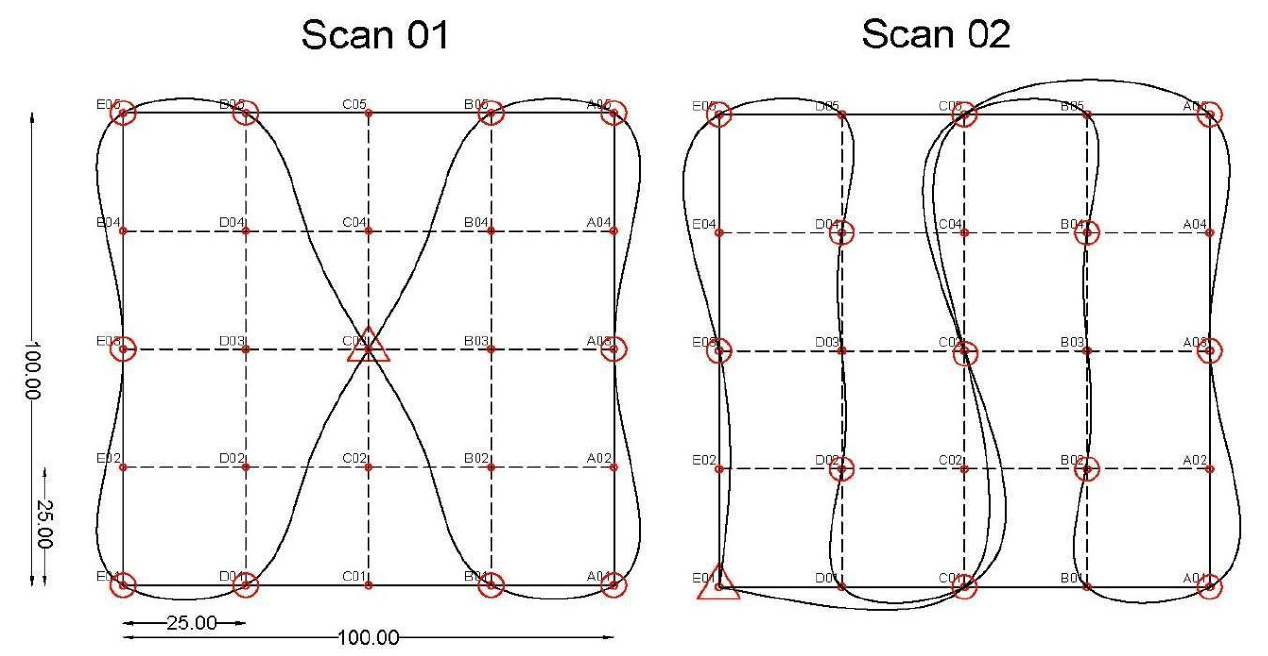
Figure 3. Representation of the 100 m × 100 m marteloscope and its 16 sections, each 25 m × 25 m, to show the two scanning paths tested. The red triangle is start‑and‑end point for each scan, the small red dots represent known points measured with Total Station, and red circles represent the Ground Control Points (GCP) along the scanning and whose positions were later measured using Total Station.